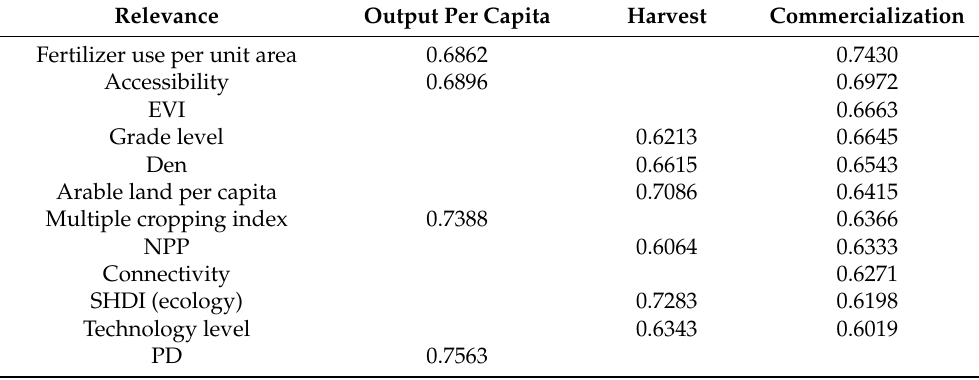
Table 8. Interactive relationship between the output, road infrastructure, and agricultural eco-environment.